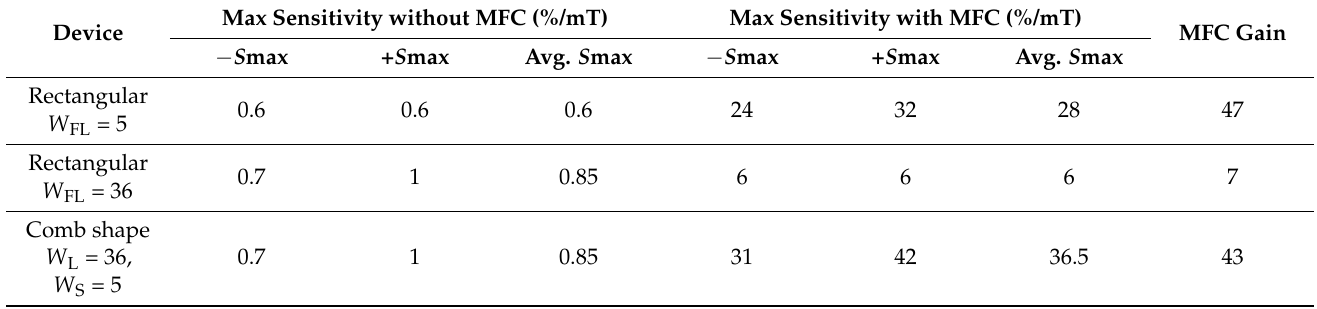
Table 2. Summary of the maximum sensitivity values and MFC gains of the rectangular and comb- shaped GMR sensors with and without MFCs. − S max and + S max indicate the maximum sensitivities measured for negative and positive H , respectively (see Figure